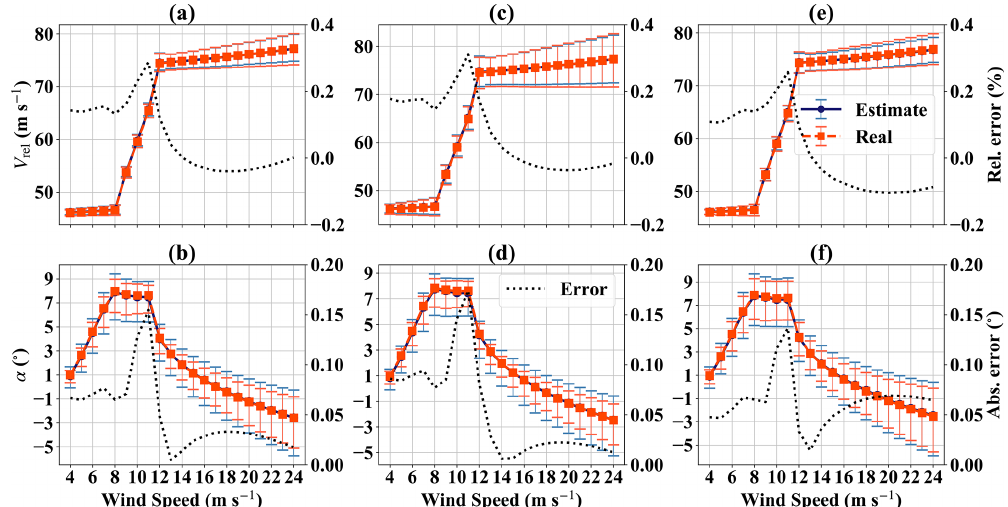
Figure 6. Observer performance for steady-state calculations. (a) V rel vs. V hub for 0 ◦ yaw simulations; (b) α vs. V hub for 0 ◦ yaw simulations; (c) V rel vs. V hub for 8 ◦ yaw simulations; (d) α vs. V hub for 8 ◦ yaw simulations; (e) V rel vs. V hub for − 8 ◦ yaw simulations; (f) α vs. V hub for − 8 ◦ yaw simulations.